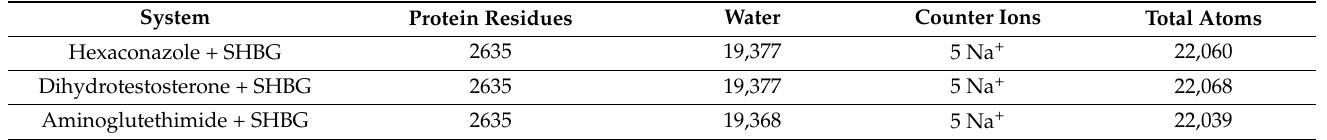
Table 4. Detailed set-up of